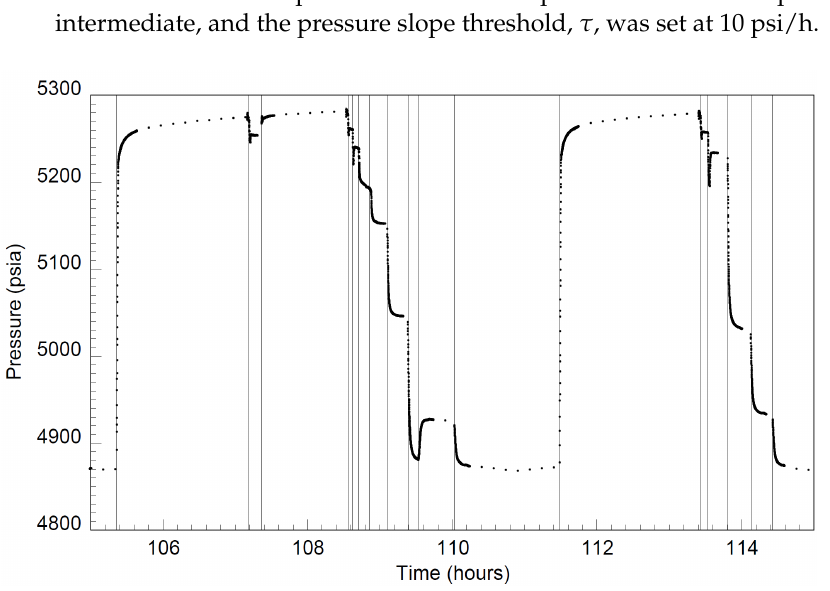
Figure 3. Detection result using Wavelet Modulus Maxima from Athichanagorn